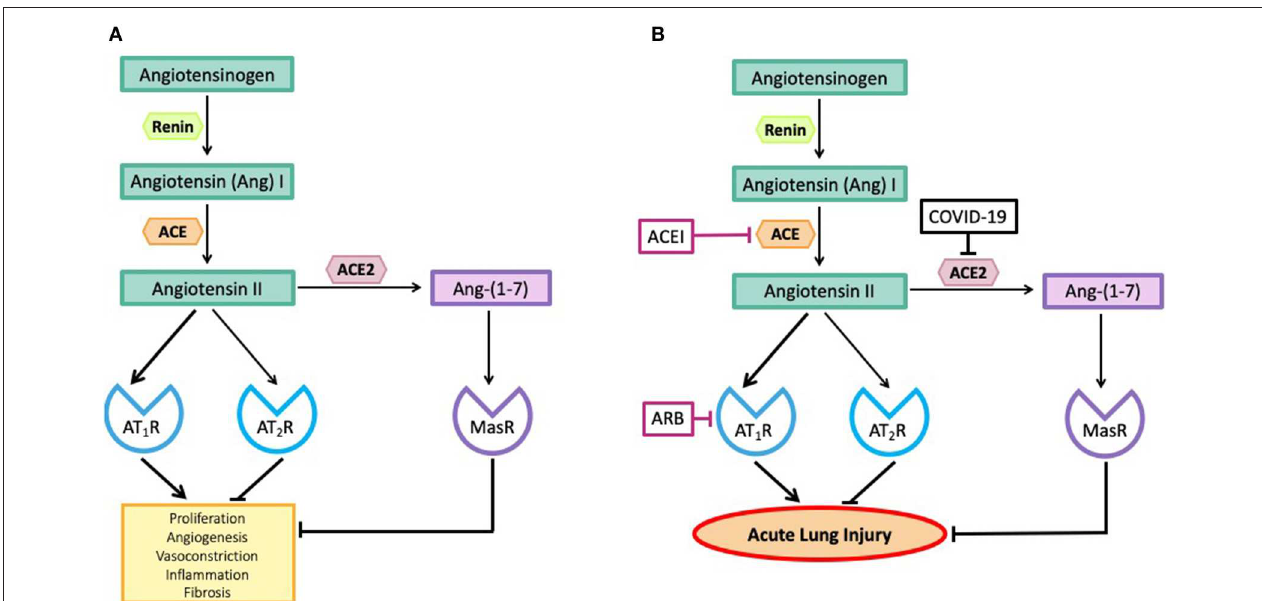
FIGURE 1 | (A) The effects of angiotensin peptides on proliferation, angiogenesis, vasoconstriction, inflammation and fibrosis. Note the effects of Angiotensin II via the Angiotensin II type I receptor (AT 1 R) are blocked by its interaction with the Angiotensin II type II receptor (AT 2 R) and by its metabolism to Ang–(1-7) acting via the Mas receptor (MasR). (B) SARS-CoV-2, by inhibiting ACE2, blocks the metabolism of Angiotensin II to Ang–(1-7) so blocking the anti-inflammatory pathway and causing high levels of Angiotensin II. Angiotensin converting enzyme inhibitors (ACEIs) prevent the formation of Angiotensin II and angiotensin receptor blocking drugs (ARBs) prevent Angiotensin II from causing inflammation and